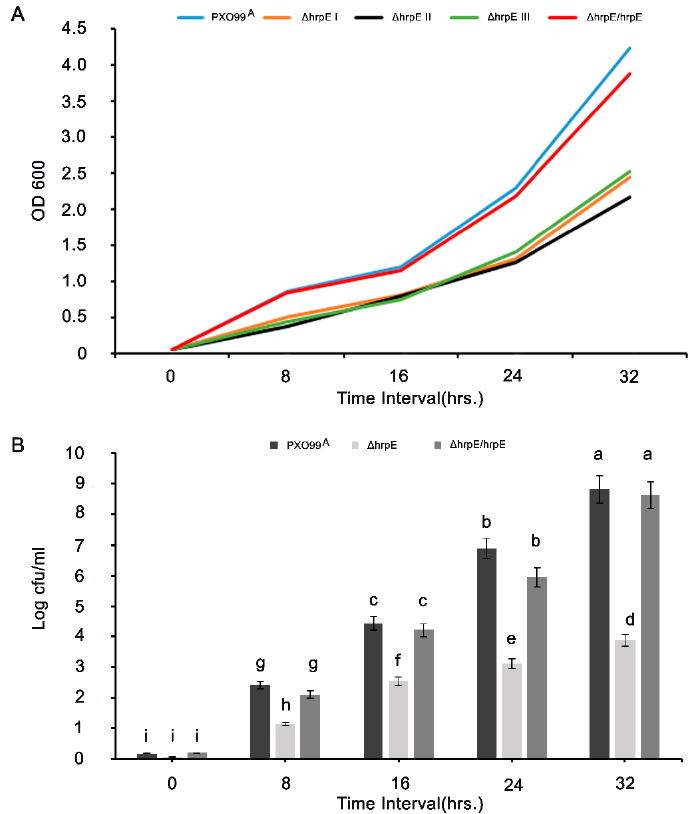
Figure 1. Growth curves of three independent Xoo ∆ hrpE colonies in comparison with WT Xoo (PXO99 A ) at di ff erent time intervals; the complementation strain Xoo ( ∆ hrpE / hrpE ) served as a control ( A ). Quantification of the log colony forming unit (log cfu/mL) of different bacterial strains on NA media ( B ). The error bars on the graph indicate standard deviations. Different alphabets on the bars